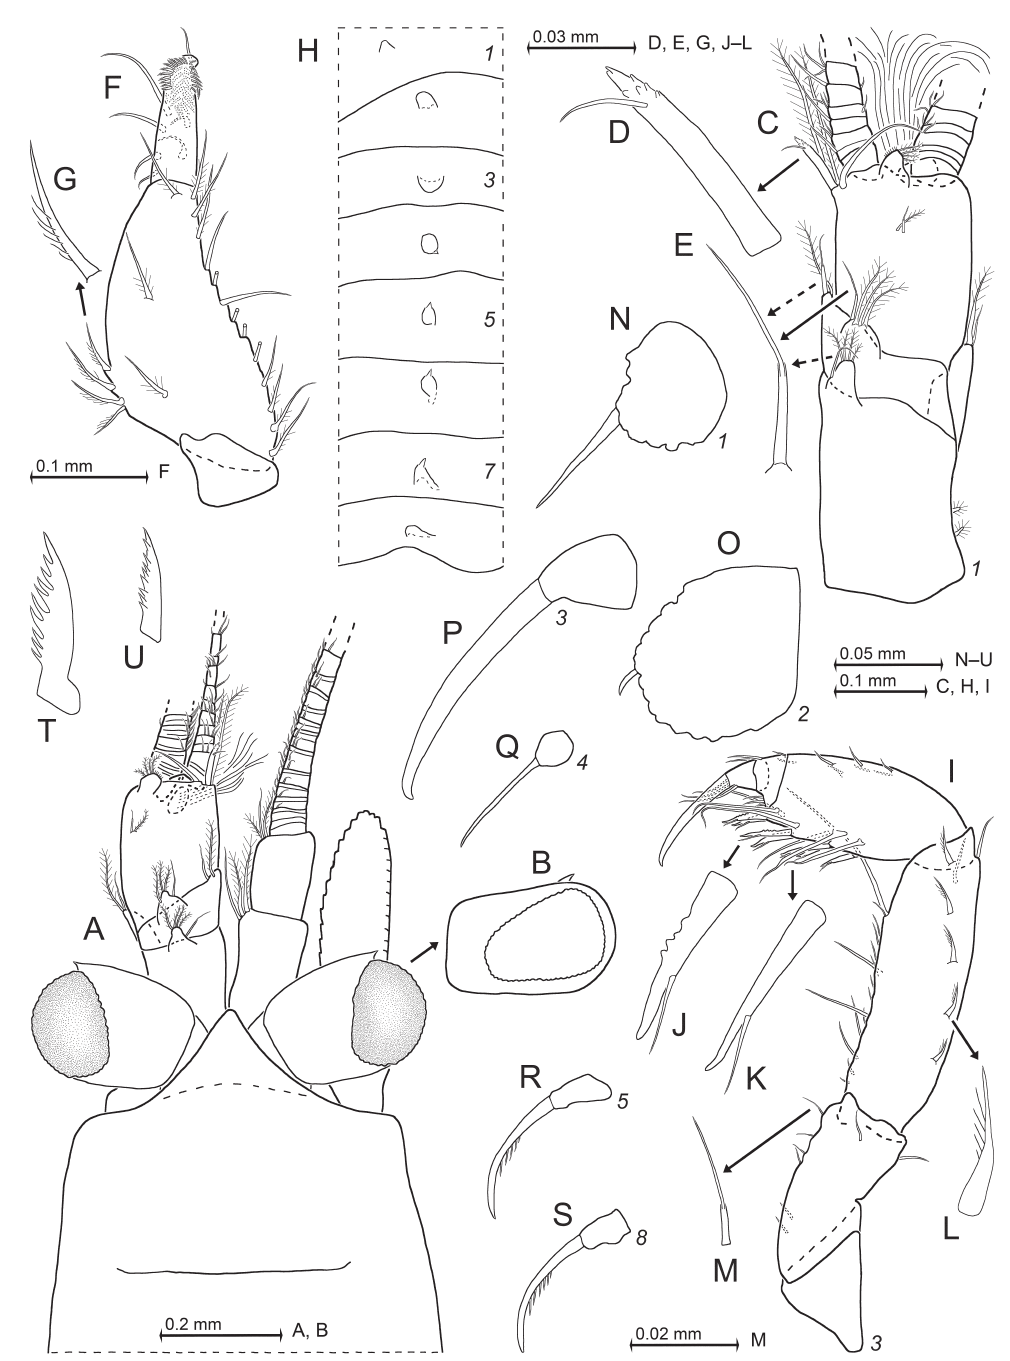
Fig. 12. Heteromysis sixi sp. nov., holotype, ♂ with body length 3.0 mm (NHMW 26964). A . Anterior body region, dorsal view; right antennula, left antenna, and setae of antennal scale omitted. B . Detail of panel (A) showing right eye in lateral view. C . Right antennula, dorsal. D–E . Details of antennula (C) showing flagellate spine (D) and an example for whip setae (E) found here and on other appendages. F . Palp of left mandible, caudal. G . Detail of panel (F) showing barbed seta from outer margin of median segment. H . Thoracic sternites 1–8 with median processes. I . Right thoracic endopod 3, rostral. J–M . Details of endopod 3 (I) showing modified spines (J–K) of carpus, barbed seta (L) of merus, and whip seta (M) from ischium. N–S . Series of dactyli with nail in thoracic endopods 1–5, 8; setae omitted. T–U . Modified spines from dorsolateral infoldings (T) and lateralia (U) of